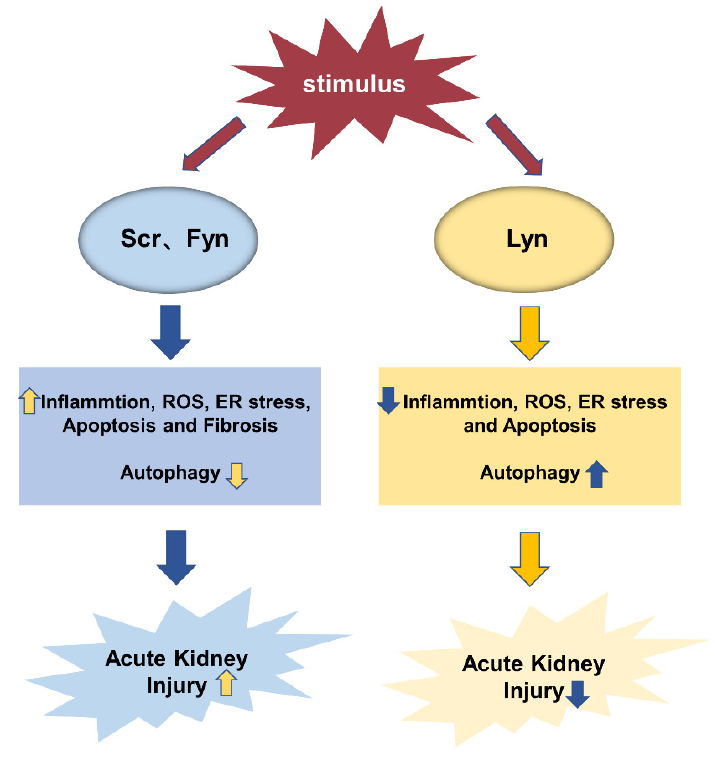
Figure 7. the role of SFKs in